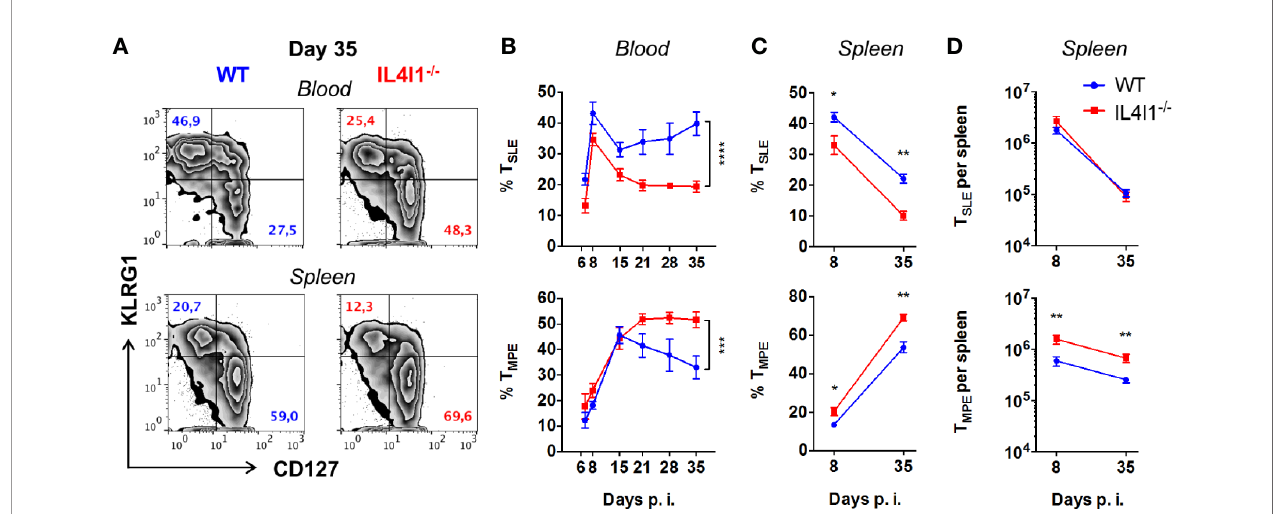
FIGURE 2 | DiminutionofGP33-speci fi cT SLE withareciprocalincreaseofT MPE inLCMV-infectedIL4I1 -/- mice.WT(blue) andIL4I1 -/- (red)micewereinfectedi.v.withLCMVon day0.H2-D b GP33 + CD8 + Tlymphocyteswere analyzedfor KLRG1andCD127expressionby fl owcytometryatvarioustimes p.i. (A) Representative dataobtainedatday35for theblood(upper panels) andspleen(lower panels). (B) PercentageofcirculatingCD127 - KLRG1 + T SLE andCD127 + KLRG1 - T MPE . *** p < 0.001; **** p < 0.0001(two-way ANOVA). (C) Percentageofsplenic CD127 - KLRG1 + T SLE andCD127 + KLRG1 - T MPE . (D) The totalnumberofGP33-speci fi csplenicT SLE andT MPE wascalculatedbasedon viablesplenocytecounts. Mean± SEM fromtwoindependent experimentswiththreetofour miceper group. * p < 0.05;** p